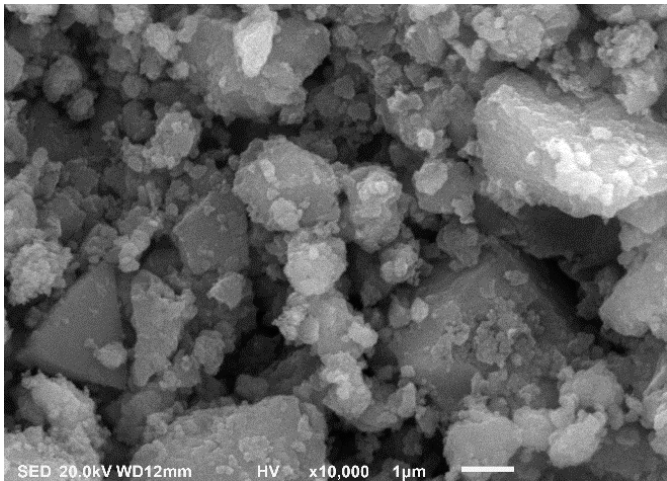
Figure 7. Scanning electron microscopy (SEM) image for TiO 2 powders synthesized by sol-gel.